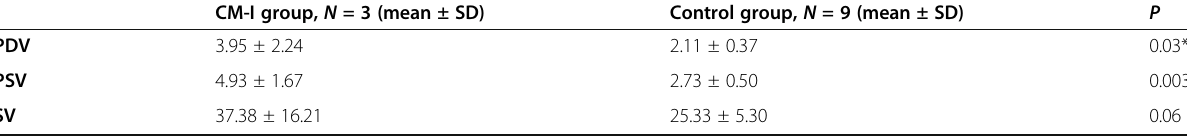
Table 3 Analysis of difference between Chiari malformation type I (CM-I) group versus control group ( t